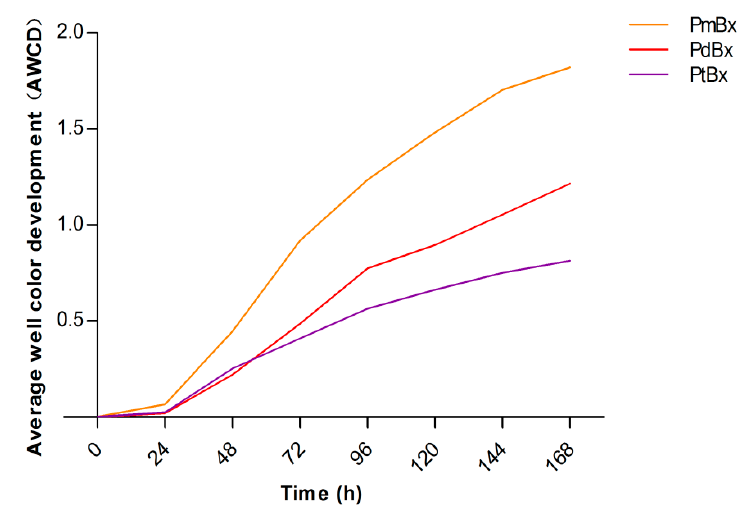
Figure 2. Average well color development (AWCD) values from Biolog EcoPlates for microbial community profiling of Bursaphelenchus xylophilus from different pine species.